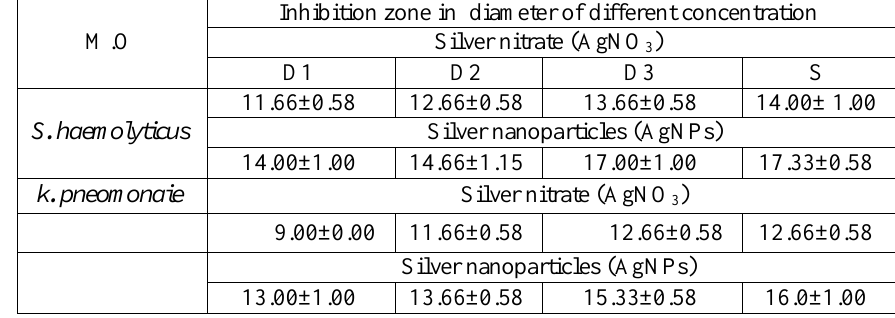
Note: The symbol (S) refers to 100%, D3 refers to 50%, D2 refers to 25%, D1 refers to